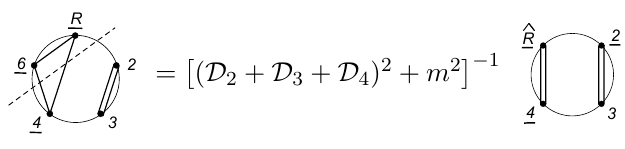
Figure 8 . Diagramatic representationn for the contribution ( I A )